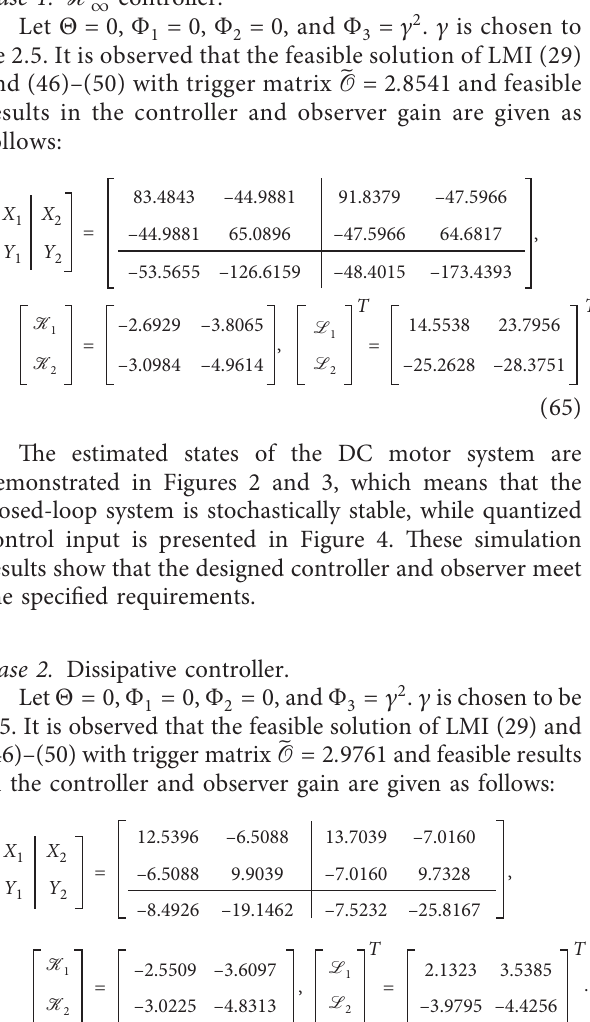
Figure 2: Response of state x